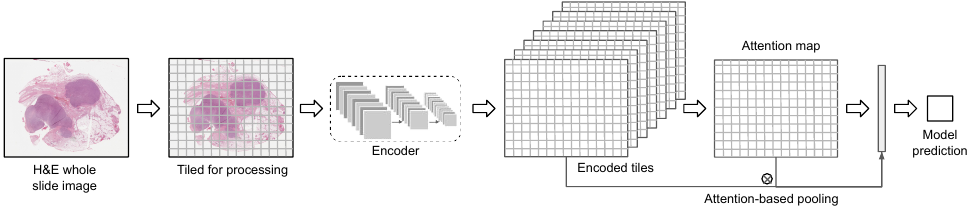
Figure 2. Multiple instance learning with an attention model: (1) WSIs are split into tiles for process- ing, (2) tiles are encoded with a CNN or some other model, (3) an attention map is calculated from the tile features, (4) tile features are aggregated using the attention weights, (5) a final class is